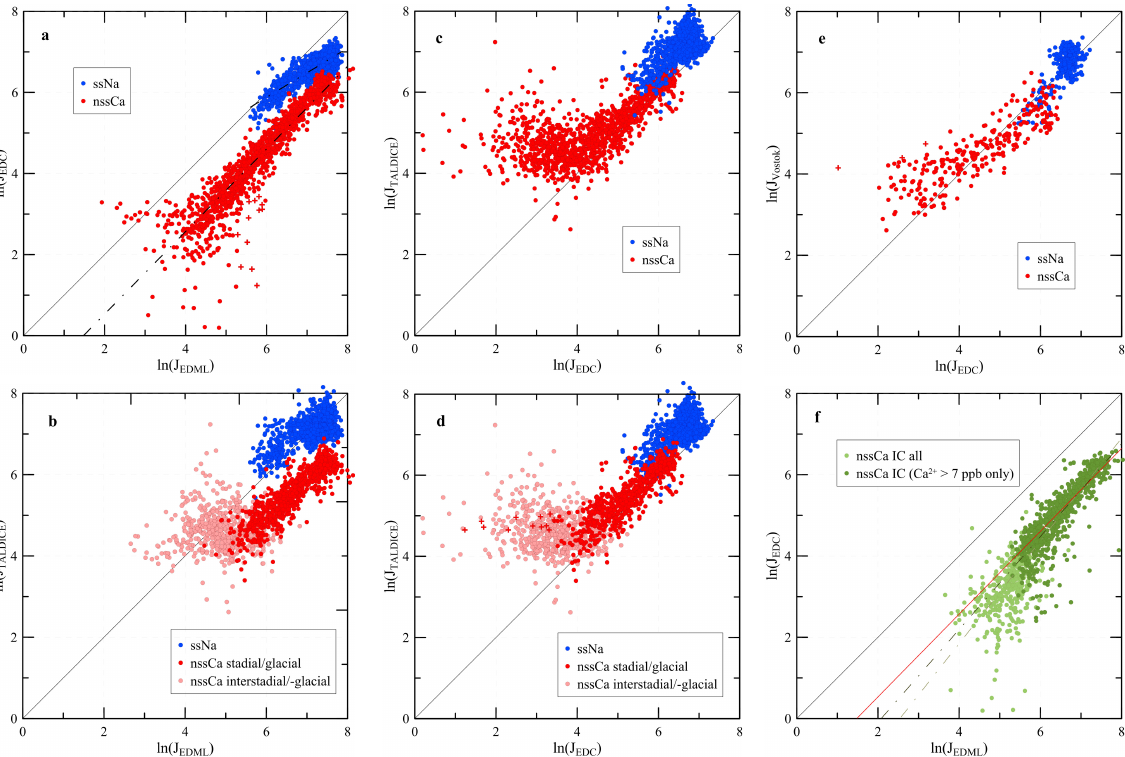
Fig. 6. Double-logarithmic scatter plots of the nssCa 2+ (red) and ssNa + (blue) fluxes in 100 yr resolution (500 yr resolution for Vostok only). (a) EDC vs. EDML. The linear regression (dash-dotted line) shows a slope of 1 for nssCa 2+ and of 0.6 for ssNa + . Outliers of the AIM 8 event are indicated as red crosses (see text for explanation). (b) TALDICE vs. EDML. Cold (dark red dots) and warm periods (light red dots) are discriminated in the nssCa 2+ scatter plot. (c) TALDICE vs. EDC. The strong correlation of (a) is no longer persistent with these two ice cores when considering all climate periods of the past 150 ka. (d) TALDICE vs. EDC. The same data as in (c) , however, cold (dark red dots) and warm periods (light red dots) are now discriminated. It becomes evident that during cold periods the linear correlation is still persistent, while for warm periods the two records are completely uncorrelated. EDC outliers during AIM 8 are indicated with red crosses. (e) Vostok vs. EDC. Vostok data were analysed using IC, thus, low nssCa 2+ fluxes are biased towards higher values in the Vostok record. Data are shown in 500 yr resolution only. (f) EDML IC data versus EDC CFA data as shown in Fischer et al. (2007a). All data are shown in light green, in dark green only the data with original Ca 2+ concentrations higher than 7 ppb. Linear regressions (dash-dotted lines) through all the IC data (light green, slope of the regression 1.26) and those above the 7 ppb threshold only (dark green, slope 1.13) show that the IC data set is indeed approaching the slope of the CFA data set as in (a) (red line, slope 1.02), when low concentration IC values are discarded.